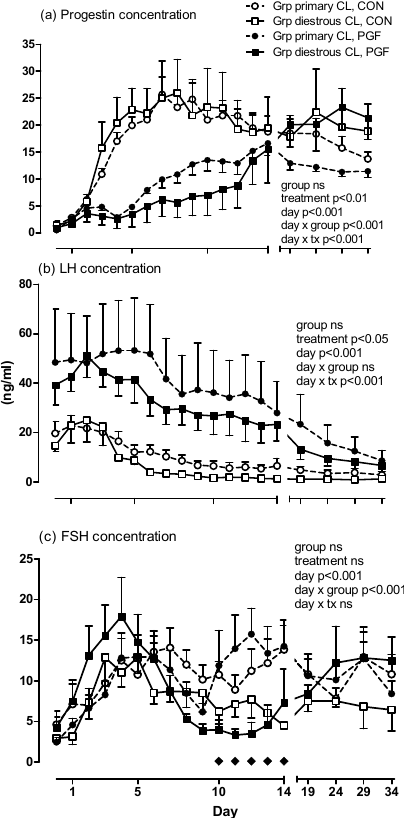
Figure 1. Concentrations of ( a ) progestogens, ( b ) LH and ( c ) FSH in control (CON) and prostaglandin F (PGF) pregnancies with mares grouped by the absence (Group [Grp] primary corpus luteum [CL]; n = 6) or presence (Grp diestrous CL; n = 5) of a diestrous ovulation in the PGF pregnancy. For group legends see Figure a. In Figure c, diamonds indicate days with diestrous ovulations in PGF pregnancies.